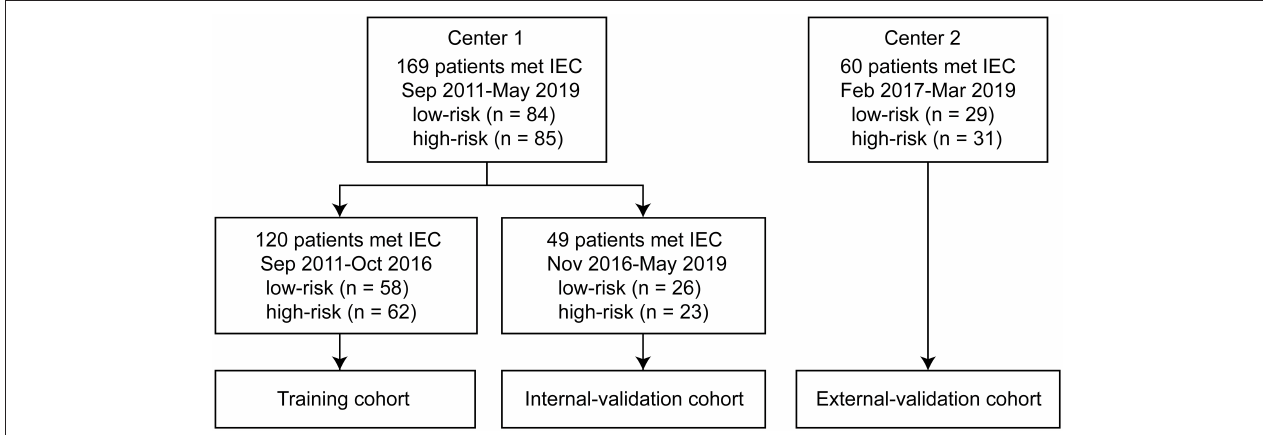
FIGURE 1 | Flow diagram of the study population. The study included 169 patients from center 1 treated between September 2011 and May 2019, and 60 patients from center 2 treated between February 2017 and March 2019. The training cohort included 120 patients (58 low-risk and 62 high-risk) treated consecutively between September 2011 and October 2016 in center 1. The internal validation cohort included 49 patients (26 low-risk and 23 high-risk) treated consecutively between November 2016 and May 2019 in center 1. The external validation cohort included 60 patients (29 low-risk and 31 high-risk) from center 2. IEC, inclusion and exclusion